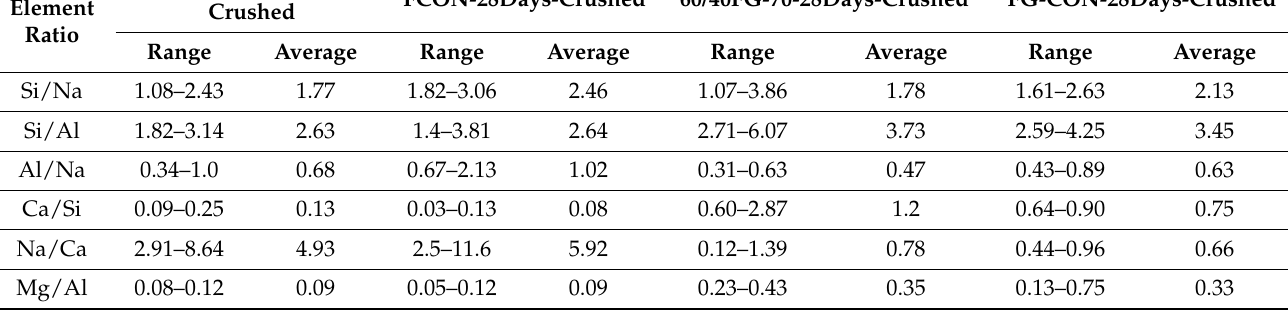
Table 4. Range and average of chemical elements ratios based on the point analysis of SEM (EDX